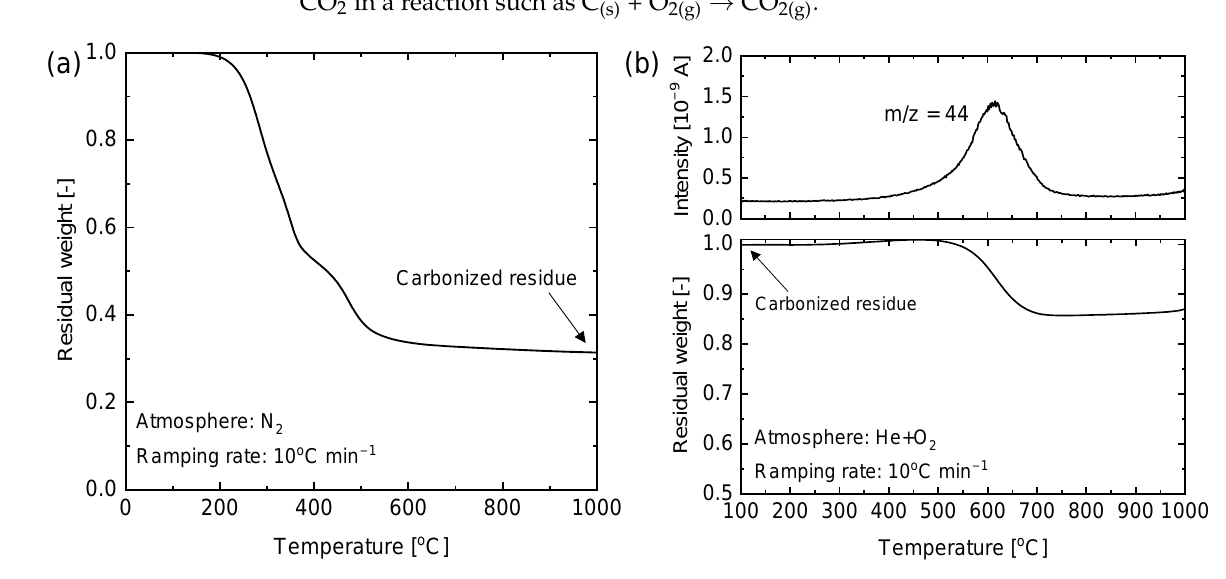
Figure 4. ( a ) Thermogravimetric analysis (TG) of the decomposition under a N 2 atmosphere of SiO 2 - ZrO 2 -polybenzoxzine resin cured at 200 °C. ( b ) Thermogravimetric analysis and mass spectrometry (TG-MS) of the decomposition under an oxidative atmosphere of the non-volatile residue derived following the TG procedure in ( a ).